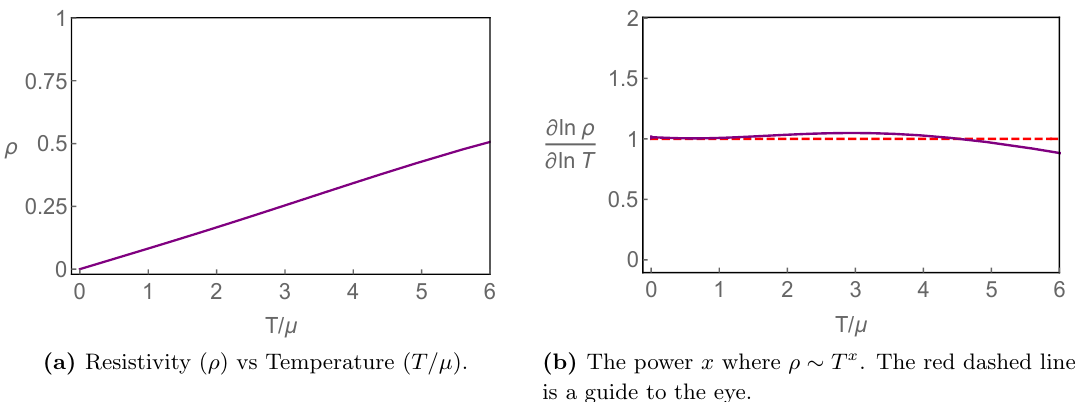
p (cid:16) (cid:17) (cid:0) 1 p ; (cid:0) 2 p ; 3 (i.e. 3 3